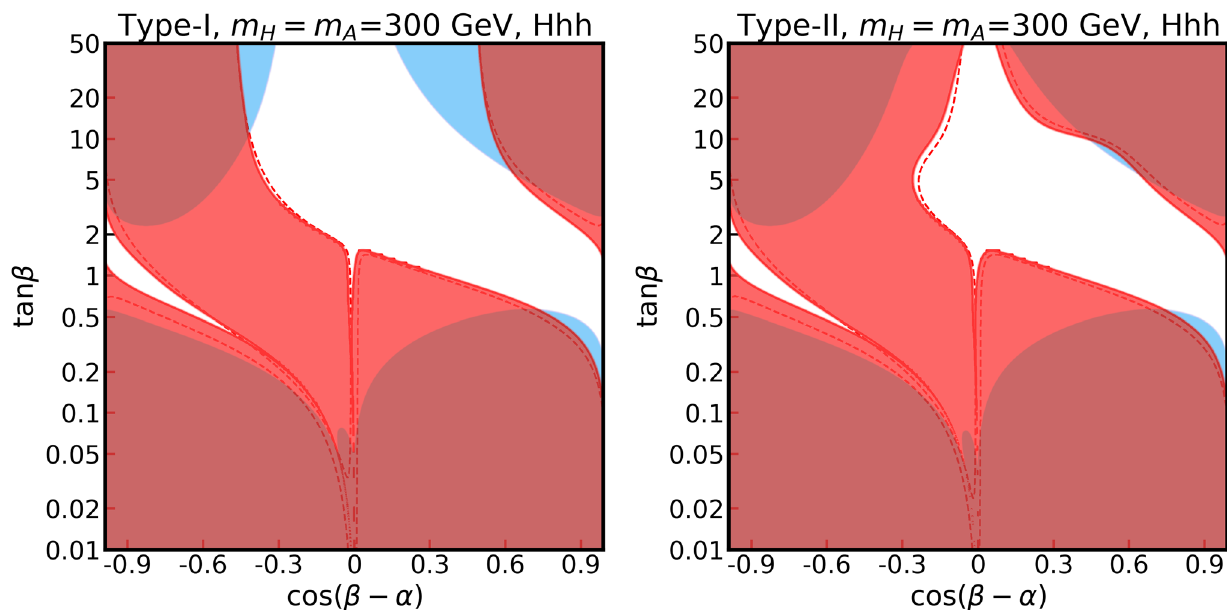
Fig. 5 Studyoftheimpactofmeasurementsinthe H → hh channelin the cos (β − α) -tan β , with degenerate heavy Higgs masses of 300 GeV. As before the dashed red lines in the figure show results based on tree- level calculations, and the excluded region at loop level are red. The left plot is for the Type-I 2HDM and the right for Type-II. Here the Higgs